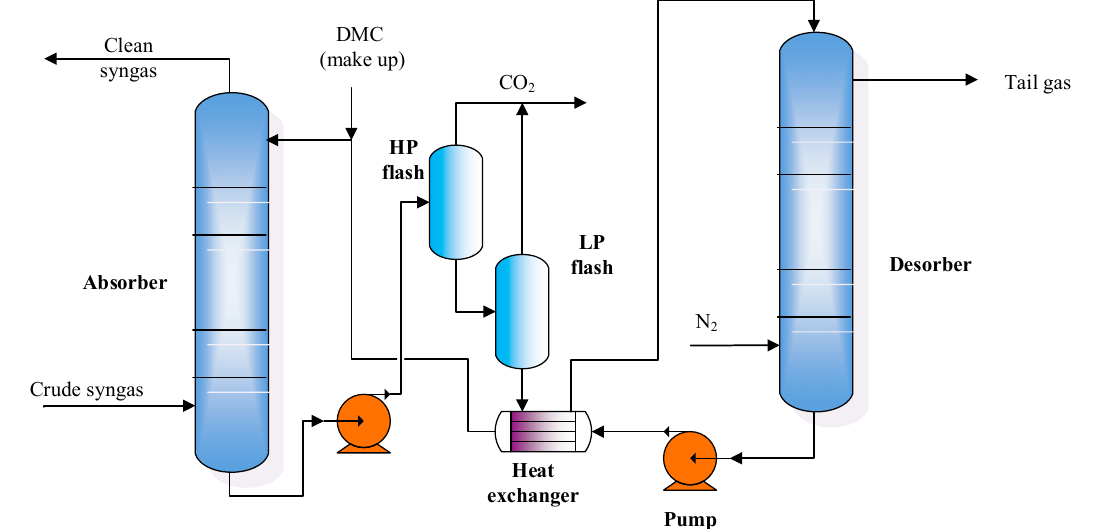
Figure 6. Simplified simulation flowsheet of the DMC technology.